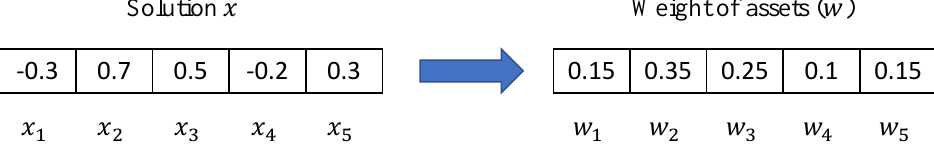
Figure 5. The Example of Transformation between the Solution of Algorithms and Weights of Assets in a